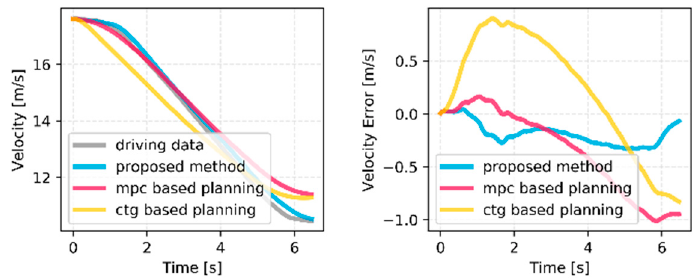
Figure 16. Velocity control results based on the various planning algorithms.